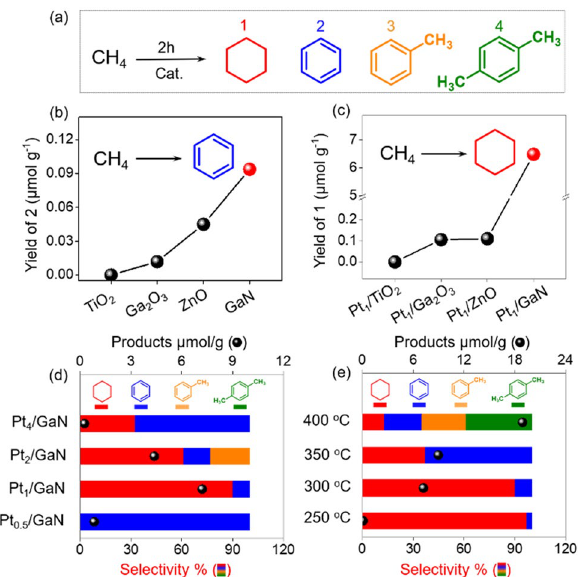
Figure 3. Methane liquefaction performance. ( a ) Schematic representation of methane-to-liquid products via thermal catalytic condition. ( b ) The yield of benzene and ( c ) cyclohexane over commonly used supports with and without loading Pt. ( d ) The selectivity and productivity of methane transformation by Pt x /GaN catalysts. ( e ) Catalytic performance of Pt/GaN under different reaction